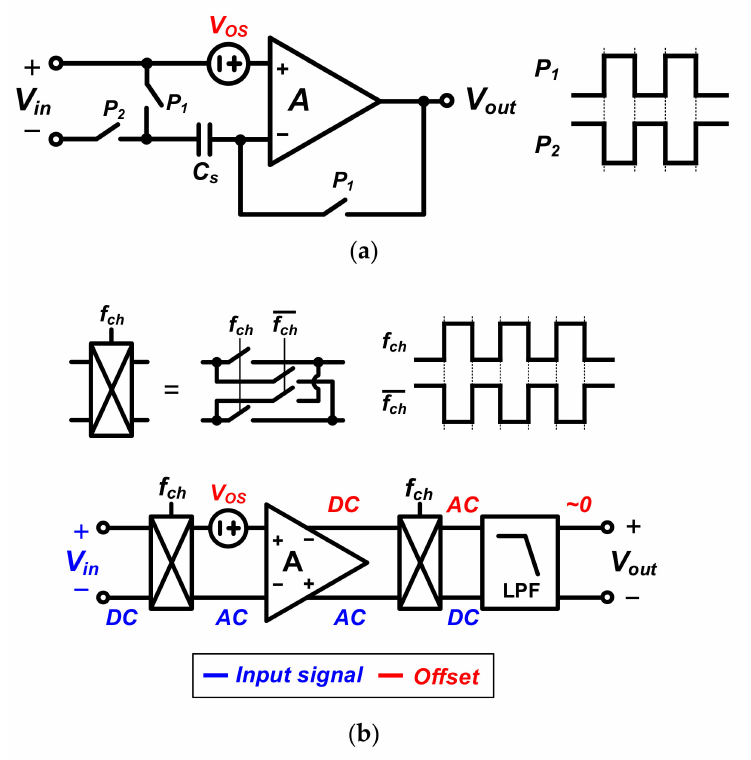
Figure 2. Conventional DOC techniques: ( a ) AZ and ( b ) chopping.